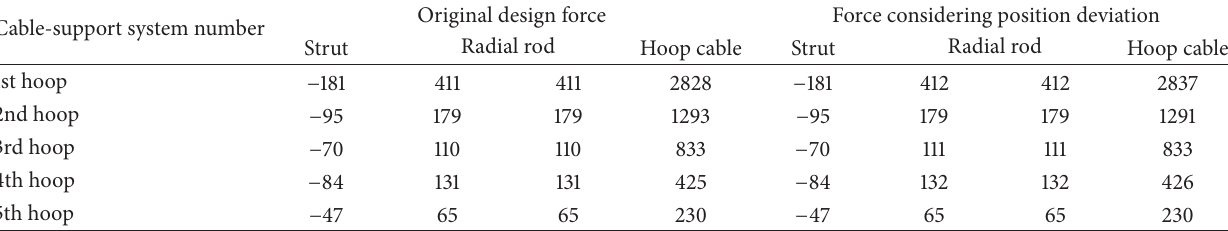
Table 3: Axial force of cable-support system at tensioned state [kN].